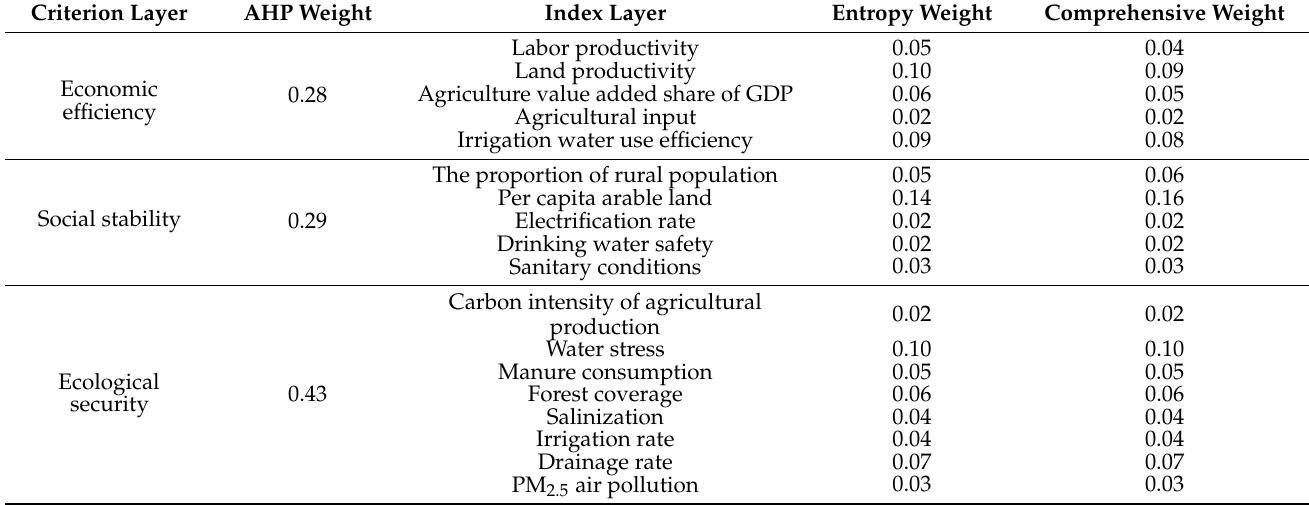
Table 3. Comprehensive weight